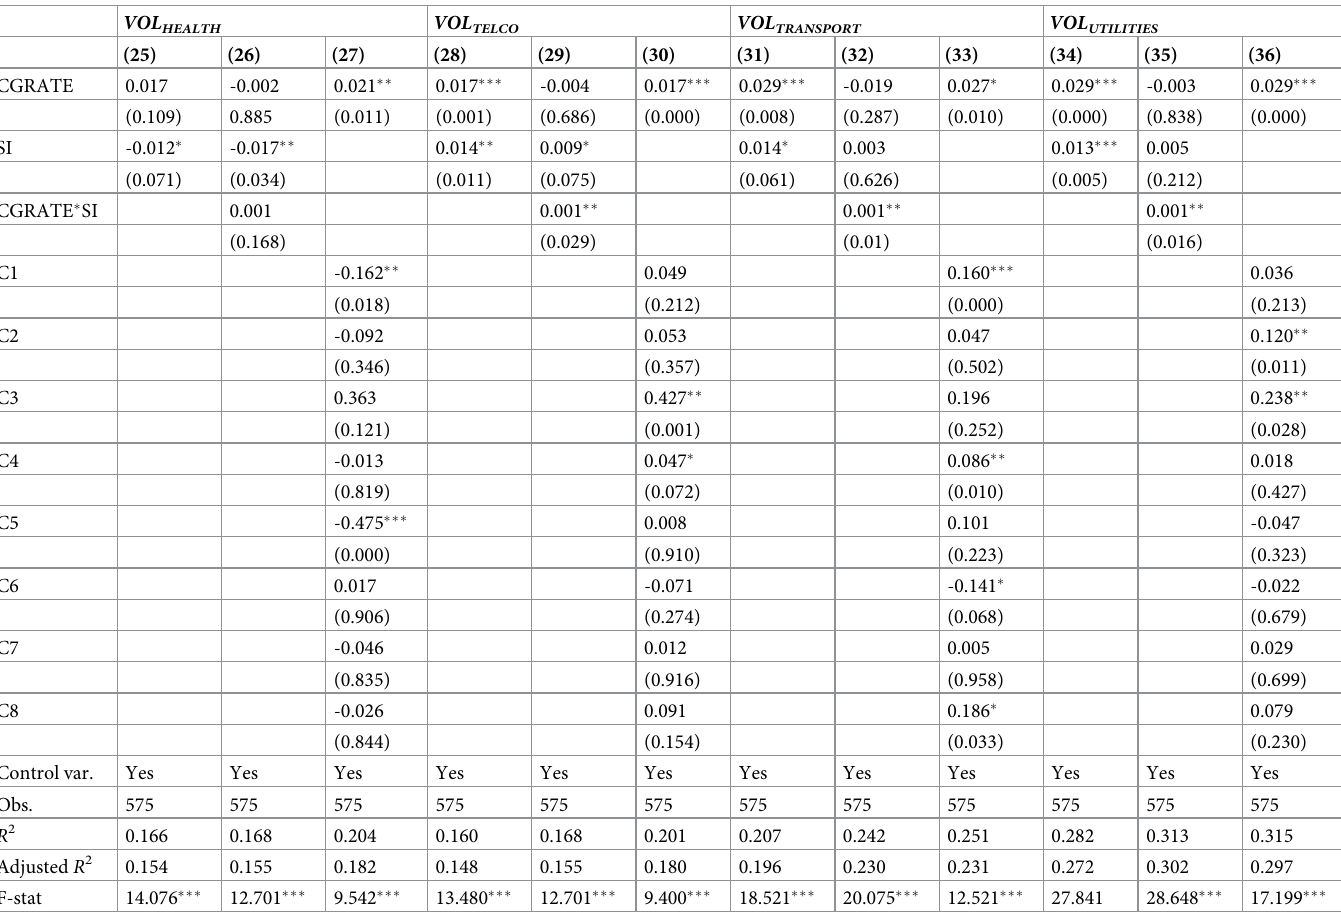
Table 9. Robustness tests: Alternative dependent variables using different sector indices